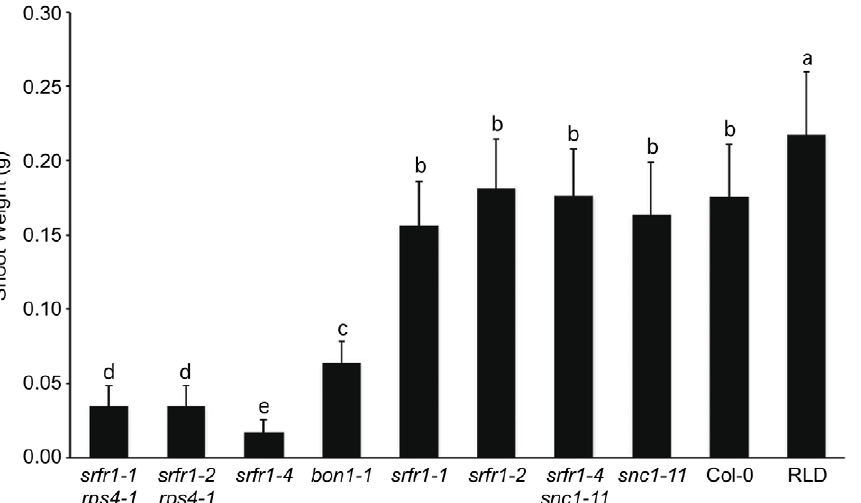
Figure 3. Stunting of srfr1-4 as measured by shoot weight is reversed by snc1-11 . The indicated plant lines were grown for three weeks in a greenhouse at 22 u C with a 16 h light/8 h dark cycle. Values represent average shoot weights of 40 to 70 plants for each line, and error bars denote standard deviation. Values labeled with different letters show significant differences as determined by Student’s t-test ( P , 0.05). This experiment was repeated once with similar results.